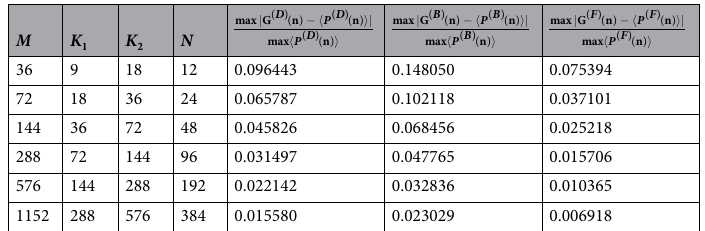
n n max ( ) ( ) for the distinguishable particles, bosons, and fermions for P n max ( )